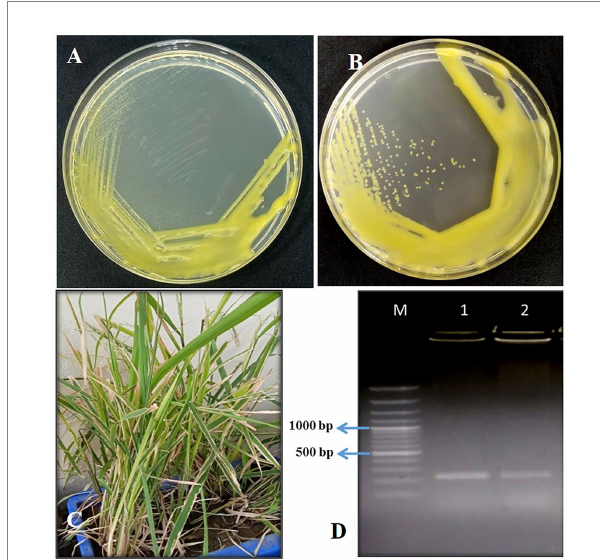
FIGURE 1 (A) Growth of Xoo culture straw yellow color smooth entire margin after 3 days; (B) slimy and glistening colony after 5-day incubation; (C) pathogenicity testing of Xoo isolates in rice pots with symptoms of BLB infection; (D) confirmation of Xoo by JLXoo-1 primer PCR with captions M: 100 bp Ladder, 1: Xoo culture, 2: Xoo re-isolated after pathogenicity test in the rice